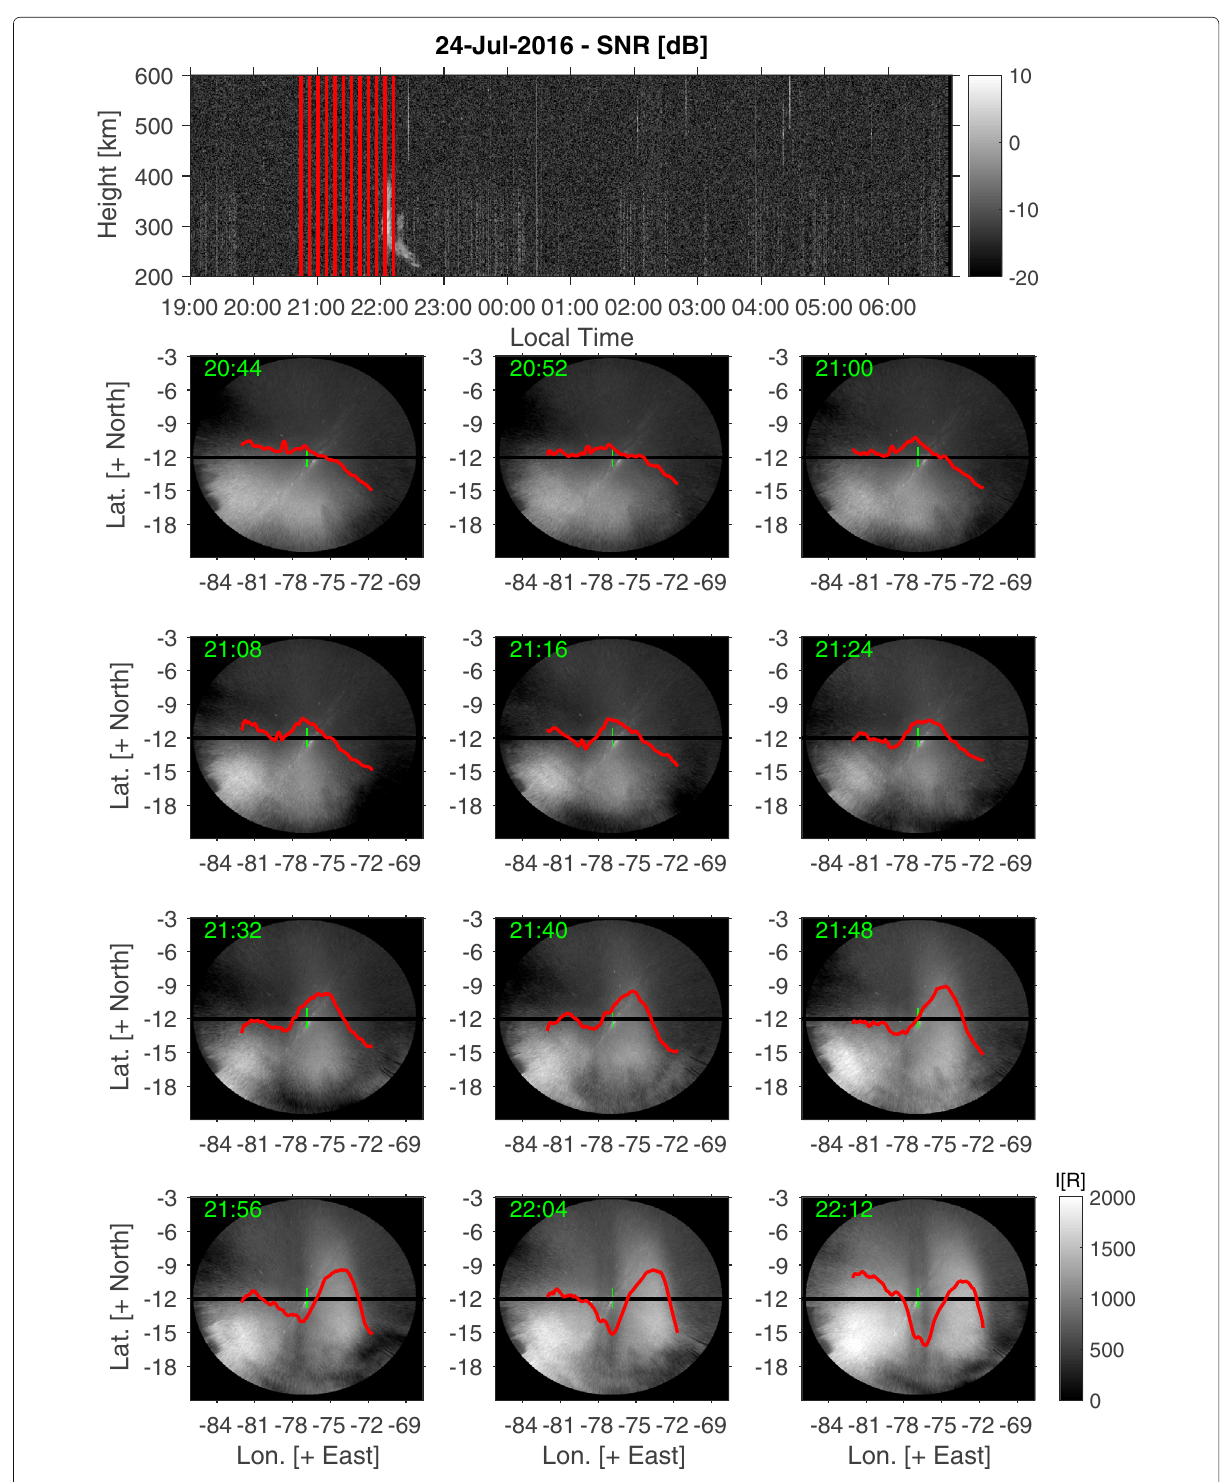
Fig. 4 The top panel shows the RTI map for AMISR-14 observations (vertical beam) made on the night of July 24–25, 2016. The bottom panels show 630 nm airglow images (intensity in Rayleighs) for different times before and during the occurrence of ESF echoes. The times for each image are indicated in the top left side of each panel and as vertical green lines in the RTI map. The solid red line in each image represents the zonal variation of the airglow near the Jicamarca’s latitude ( ∼ − 12° N). The black solid line is a reference base line to help the reader identify fluctuations in airglow if